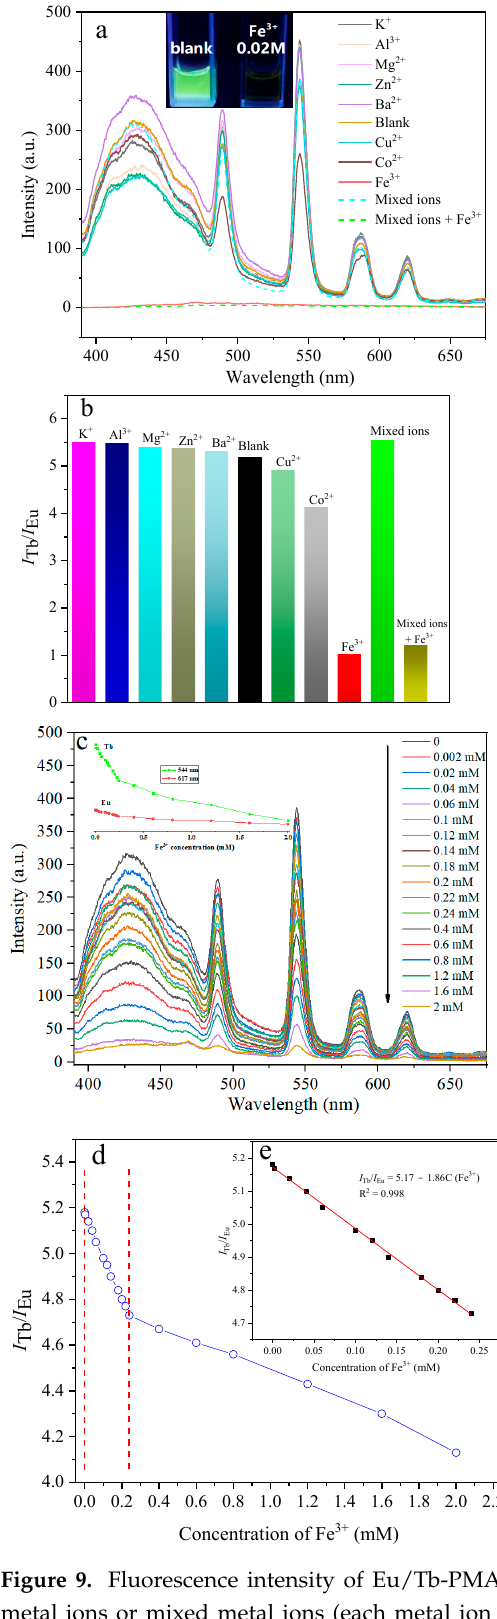
Figure 9. Fluorescence intensity of Eu/Tb-PMA-MPEG in the absence or presence of different metal ions or mixed metal ions (each metal ion concentration: 0.02 M) ( a ); the I Tb / I Eu plots of Eu/Tb-PMA- MPEG in the absence or presence of different metal ions or mixed metal ions ( b ); ion concentration- dependent fluorescence intensity of Eu/Tb-PMA-MPEG in the absence of Fe 3+ ( c ); the I Tb / I Eu vs. Fe 3+ plots from 0 to 2 mM ( d ) and the red solid line represents the theoretical fit ( e ). Further, for a sensitivity study, different concentrations of Fe 3+ in the range of 0.002– 2 mM were measured. Figure 9c shows the fluorescence spectra of the nanoscale Eu/Tb- PMA-MPEG solutions after adding various amounts of Fe 3+ ions under the excitation wavelength of 360 nm. The fluorescence intensities I PMA-MPEG (the very broad peak about 390–480 nm), I Tb (the peak at 544 nm) and I Eu (the peak at 617 nm) all decrease with the increase in Fe 3+ concentration. Increasing Fe 3+ concentration leads to an obvious drop in Tb 3+ emission intensity, whereas the emission intensity of Eu 3+ exhibits a slow decrease. This different Fe 3+ -dependent emission pattern of 5 D 4 → 7 F 5 transition (Tb 3+ , I Tb ) and 5 D 0 → 7 F 2 transition (Eu 3+ , I Eu ) in the Eu/Tb-PMA-MPEG can used as a promising candidate for self- referencing sensor. As seen from Figure 9d, the change rule between I Tb / I Eu and the con- centration of Fe 3+ was clear. The plot in Figure 9e shows an adequate linear fit with a cor- relation coefficient (R 2 ) of 0.998 between I Tb / I Eu and the concentration of Fe 3+ in the concen- tration range of 0–0.24 mM, and the linear equation is I Tb / I Eu = 5.17–1.86C (Fe 3+ ). The limit of detection (LOD) was found to be 0.94 μ M, a lower value compared with that previously reported in the literature [47,48]. Figure S5 presents the CIE chromaticity of the Eu/Tb- PMA-MPEG solutions after adding various amounts of Fe 3+ ions under the excitation wavelength of 360 nm. The quenching mechanism could be explained as the interaction between Fe 3+ and the PMA-MPEG 1.4 ligand reduces the energy transfer efficiency from PMA-MPEG 1.4 ligands to Eu 3+ and Tb 3+ ions, especially Tb 3+ ions in Eu/Tb-PMA-MPEG, as seen in Figure 9c, and this effect increases with the addition of Fe 3+ ; thus, the luminescence of the nanomaterial is quickly reduced. In aqueous media, the characteristic emission intensity ( I Eu ) of Eu 3+ ions at 617 nm in Eu-MPA-MPEG is very low due to the quenching caused from water (as shown in Figure S2a), but for Eu/Tb-PMA-MPEG (Figure S3a), the I Tb of Tb 3+ ions at 544 nm is much higher than thw I Eu of Eu 3+ ions at 617 nm, and I Eu in Eu/Tb-PMA-MPEG is also higher than that in Eu-PMA-MPEG, which is ascribed to the energy transfer between lanthanides [49]. Such a self-referring strategy amplifies the relative emission ratios, which would also en- hance the luminescence signals and facilitate the detection of the analytes in aqueous sys- tems. Using nanoscale Ln-assemblies, especially those easily dispersed in liquid, to achieve fluorescence detection is fast, simple and accurate [50,51]. The mixed Eu/Tb-PMA-